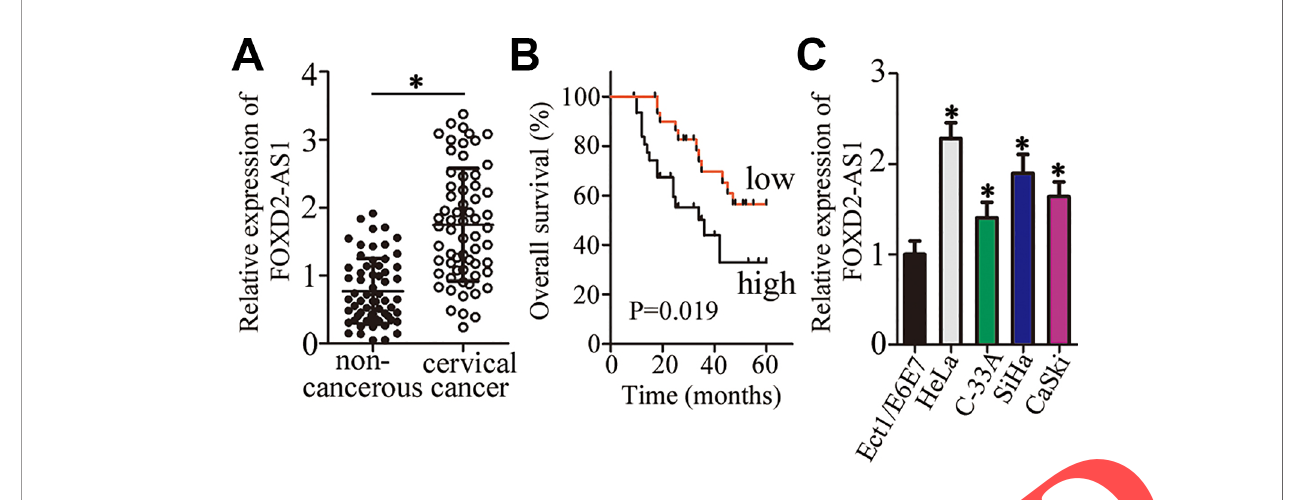
FIGURE 1 | FOXD2-AS1 is upregulated in cervical cancer tissues and cell lines. (A) RT-qPCR was carried out to analyze FOXD2-AS1 expression in 63 pairs of cervical cancer tissue samples and adjacent noncancerous tissues. *P < 0.05 vs noncancerous tissues. (B) The Kaplan – Meier survival curve of patients with cervical cancer classi fi ed as low- and high- FOXD2-AS1 groups based on a median expression level of FOXD2-AS1 . P = 0.019. (C) Expression of FOXD2-AS1 in four cervical cancer cell lines (HeLa, C-33A, SiHa, and CaSki) and a normal human cervix epithelial cell line (Ect1/E6E7) was determined by RT-qPCR. *P < 0.05 vs Ect1/ E6E7 ( Figure 1C , P < 0.05). These fi ndings suggested that FOXD2-AS1 may be closely related to the aggressiveness of cervical cancer.